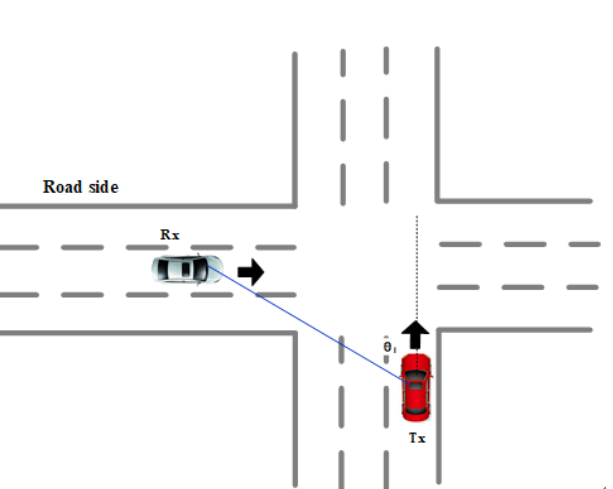
Figure 10. Schematic diagram of the relative speed of the two cars in the orthogonal direction.